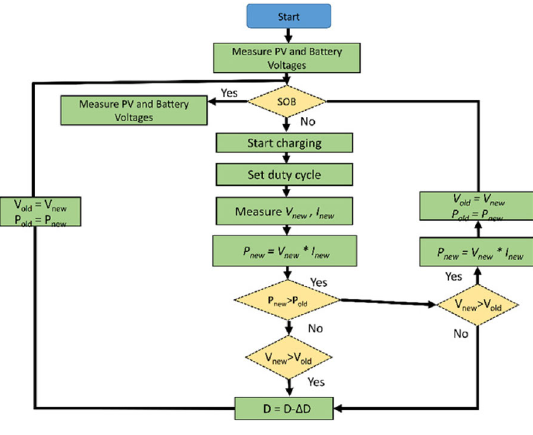
Table 1 Solar panel specification at 1000 W/m 2 and